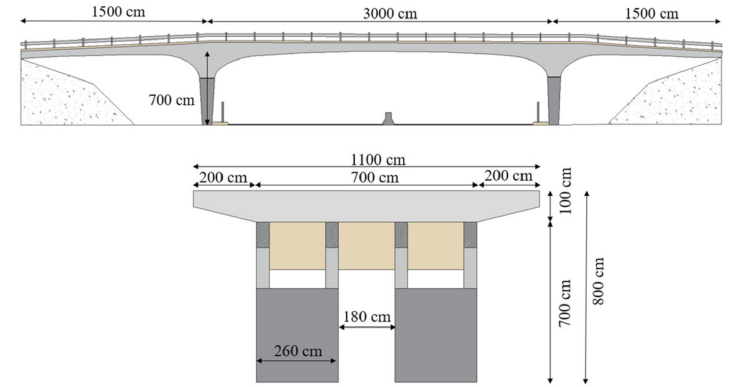
Figure 2. Front elevation and section of Interchange 12